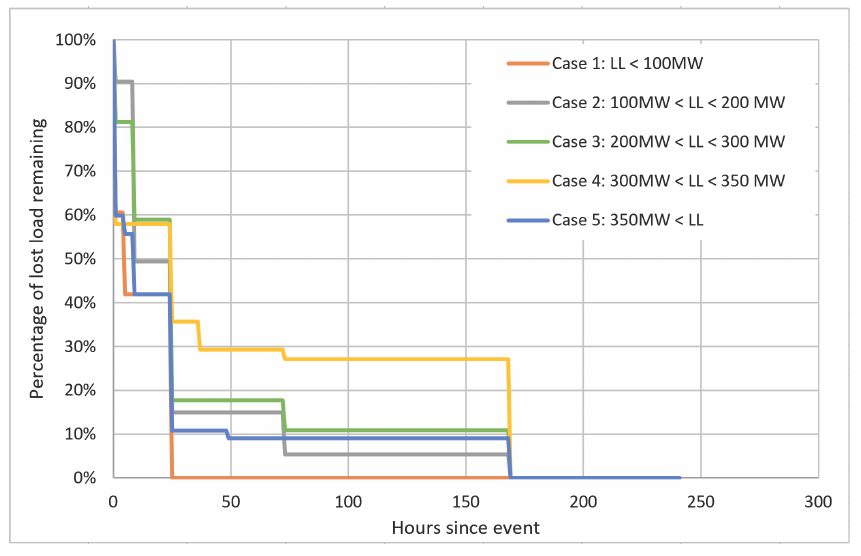
Figure 7. Outage duration for 5 cases with load loss (LL) ranging from 30 MW to 380 MW.